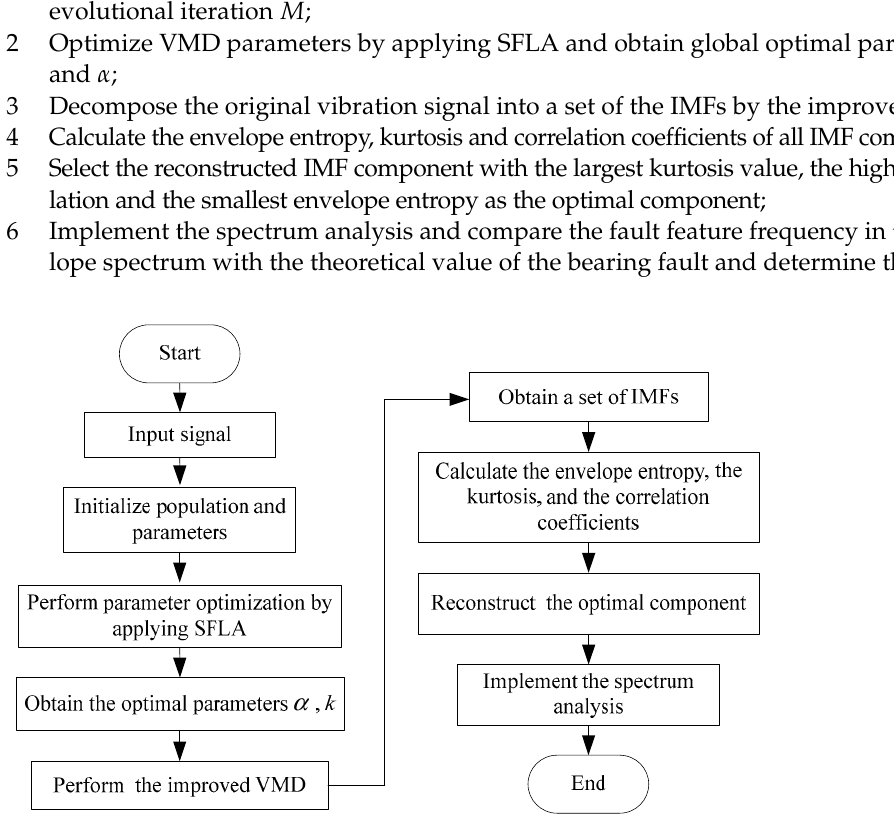
Figure 2. Flowchart of the fault feature extraction by using parameters-optimized Variational mode decomposition (VMD).